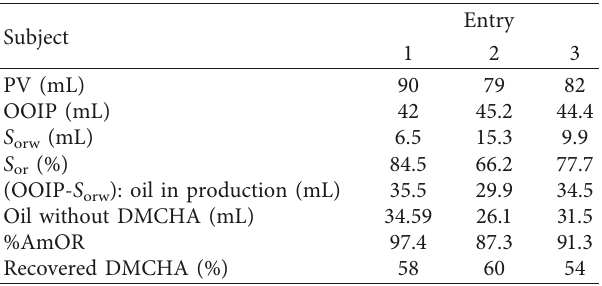
Scheme 2: DMCHA extraction activity and switchability Table 3: Summary of the results obtained in the sand-pack ex- periments using DMCHA.